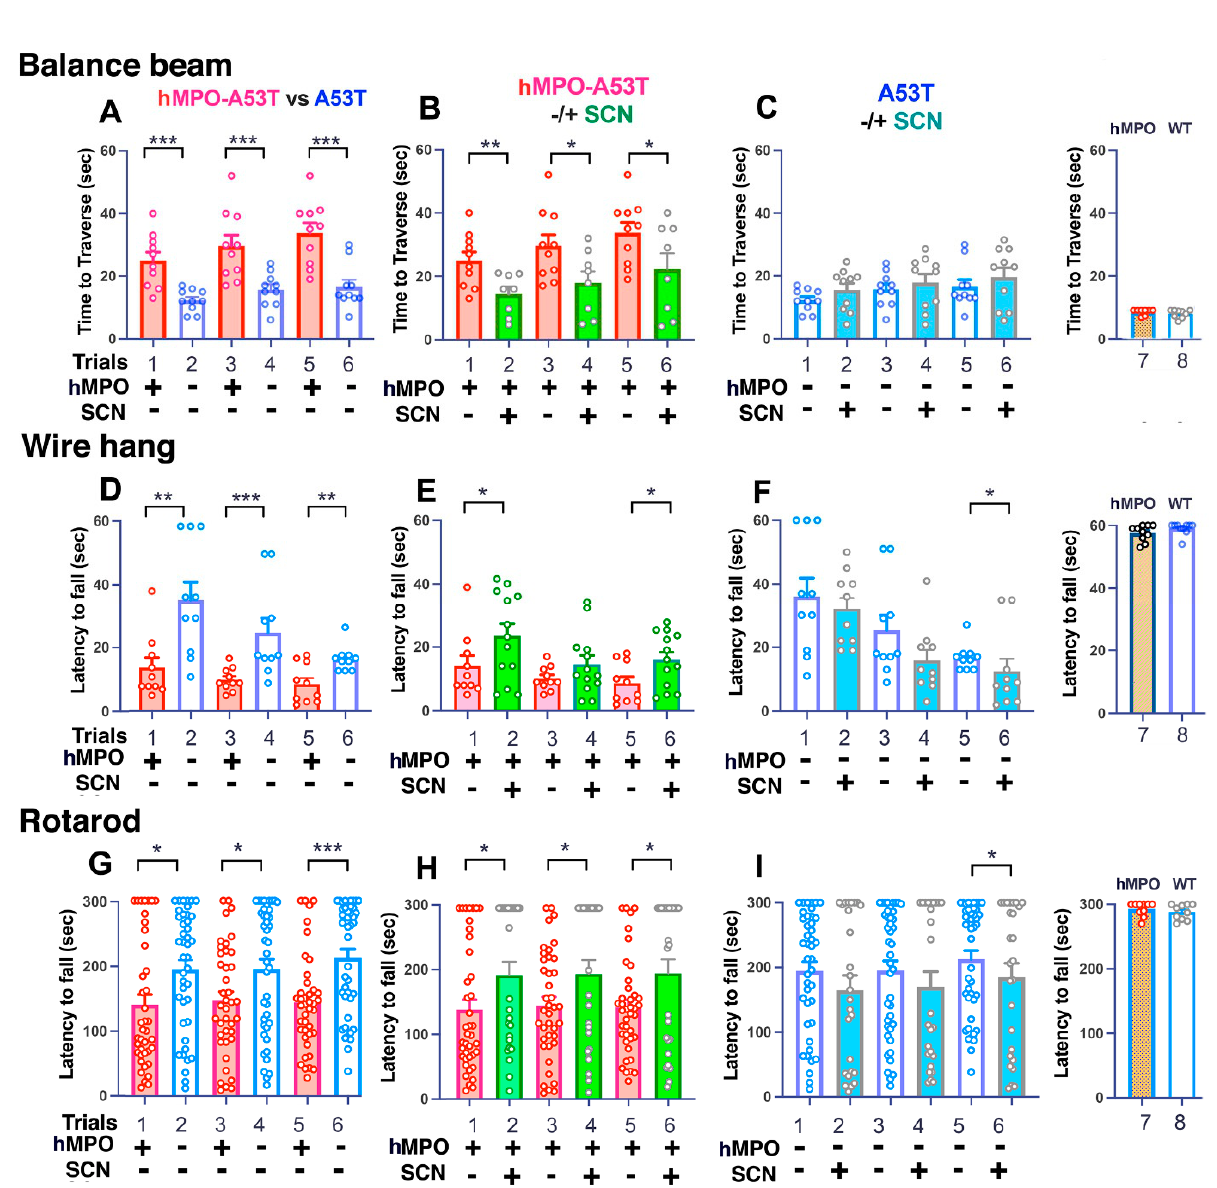
Figure 1. Impaired motor abilities in hMPO-A53T mice compared to A53T. ( A ) Balance beam anal- ysis was performed with genotypes hMPO-A53T (n = 10) (lanes 1,3,5) versus A53T (n = 10) (lanes 2,4,6). Only male mice were used in these experiments. Three consecutive trials were performed for each group with rest intervals of 5 min. ( B ) hMPO-A53T (n = 10) (lanes 1,3,5) vs. hMPO-A53T SCN − treated (n = 8) (lanes 2,4,6). ( C ) A53T (n = 10) (lanes 1,3,5) vs. A53T SCN − treated (n = 10) (lanes 2,4,6). hMPO mice (n = 10) (lane 7) vs. WT (C57Bl/6) (n = 9) (lane 8). Only the third trial is shown for WT and hMPO mice. Trials A lanes 1,3,5 are the same as B lanes 1,3,5. Trials A lanes 2,4,6 are the same as C lanes 1,3,5. ( D – F ) The wire hang was performed with the indicated genotypes as in panels A,B,C (n = 10 A53T, n = 10 hMPO-A53T, n = 10 hMPO, n = 10 WT). Three trials with rest intervals were performed for each group. Only the third trial is shown for WT and hMPO mice. ( G – I ) Rotarod analysis was performed with the genotypes indicated in panels A,B,C (n = 39–44 for each group, n = 10 hMPO, n = 10 WT). Three consecutive trials were performed for each group with rest intervals of 5 min. Only the third trial is shown for WT and hMPO mice. Behavior data were analyzed using a one-way analysis of variance (ANOVA) followed by Dunnets post- hoc test using GraphPad Prism v9. Data are represented as mean +/ − S.E.M. (* p < 0.01, ** p < 0.005, *** p <